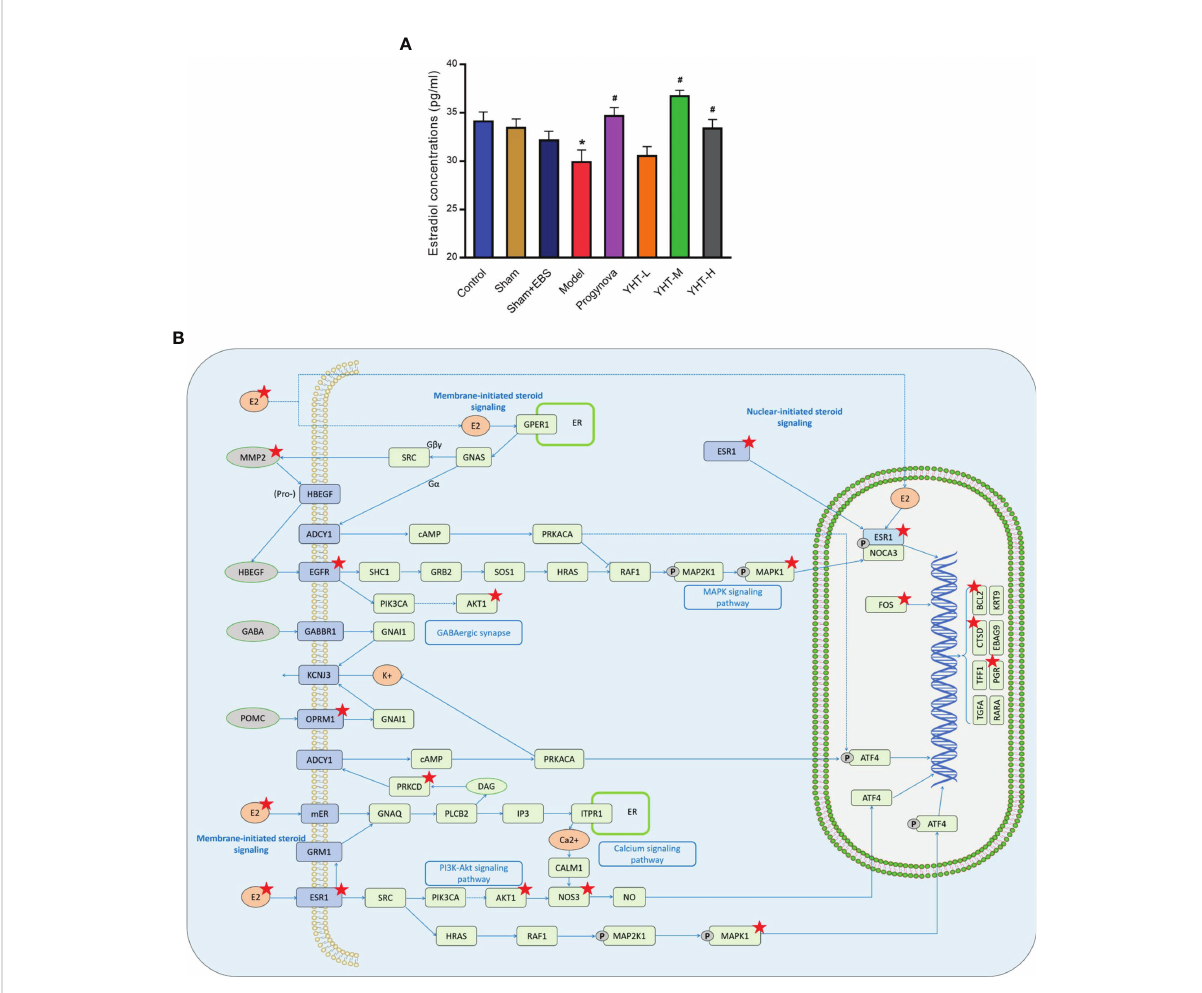
FIGURE 8 Effects of YHT on the serum estradiol concentrations in menopausal mice. (A) Serum estradiol concentrations. *p < 0.05 vs control group; #p < 0.05 vs model group. (B) The estradiol signaling pathway. EBS, empty bottle